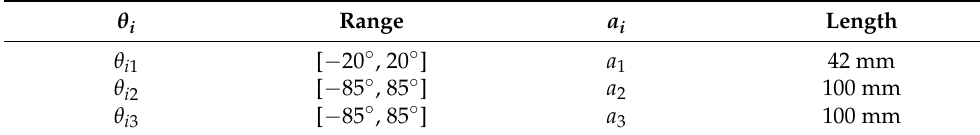
Table 2. Actual values of D–H parameters. θ i Range a i Length θ i